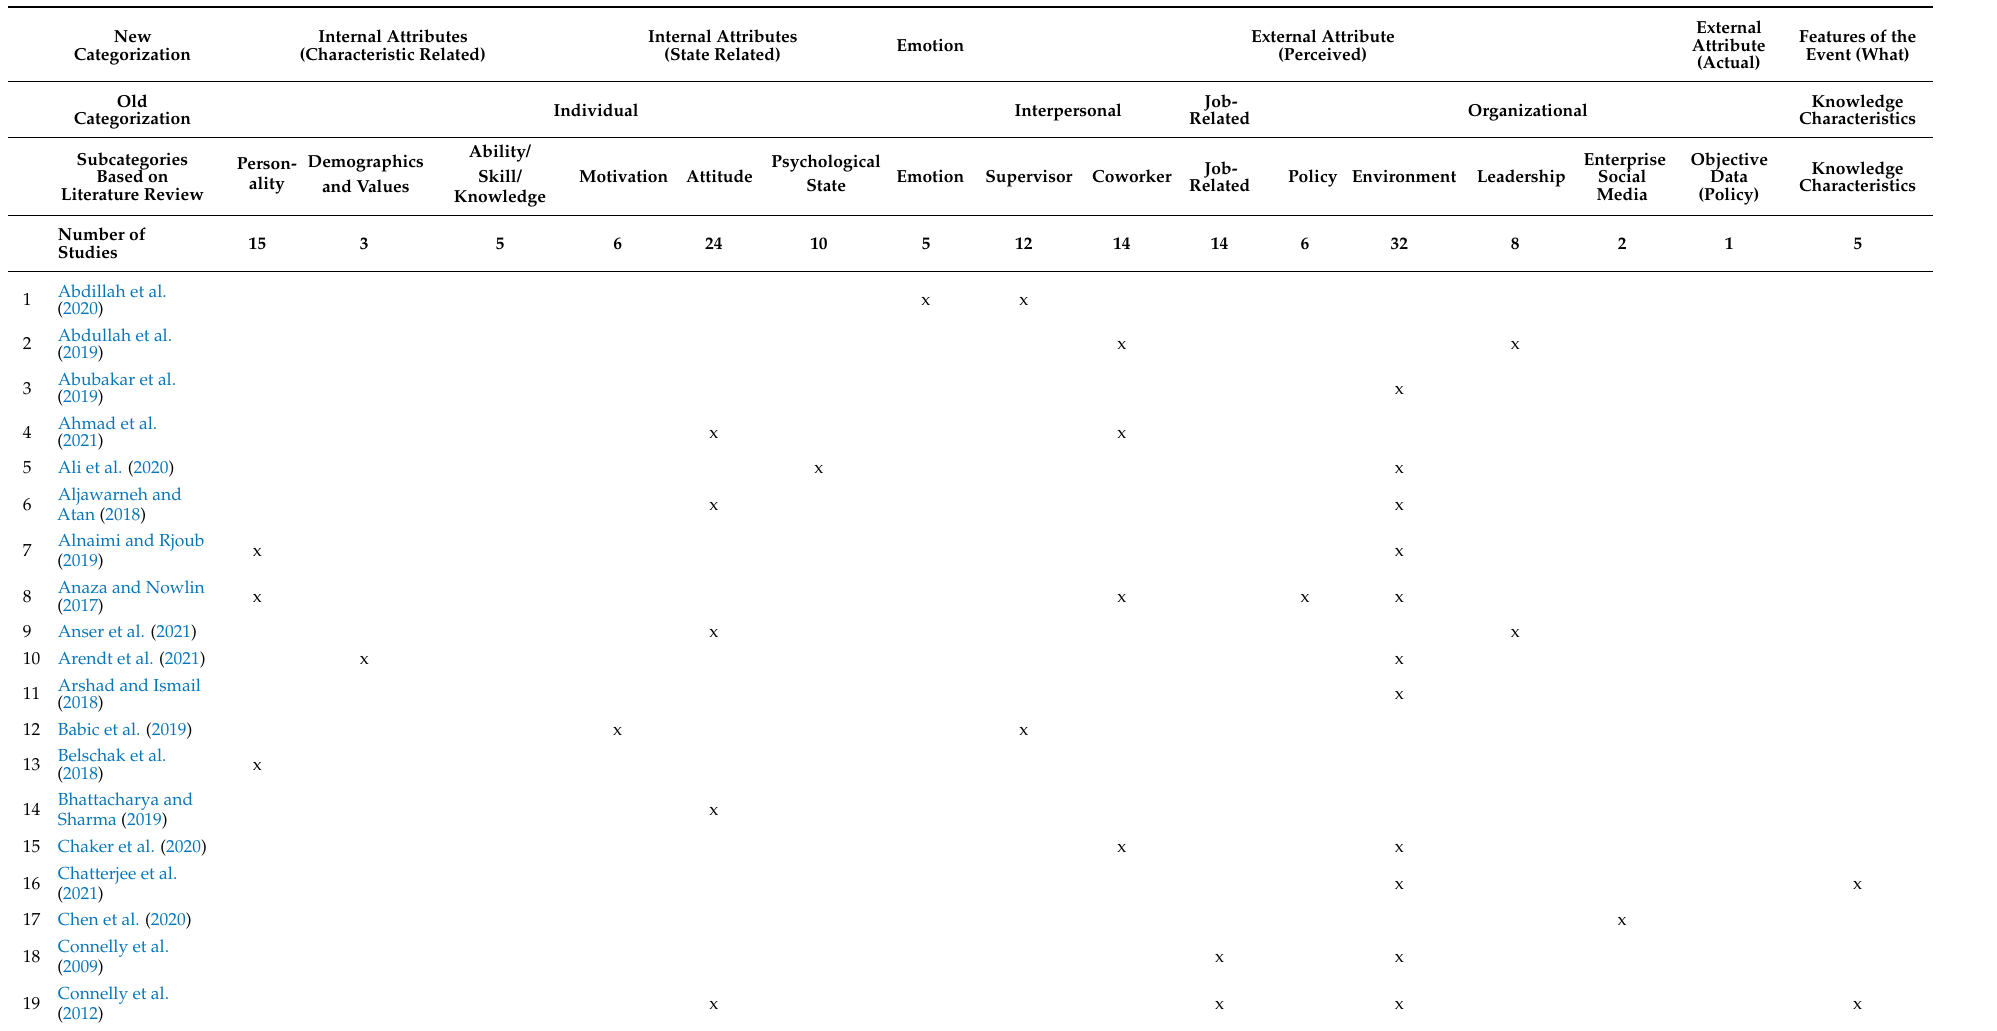
Table 2. Summary of the categories of antecedent variables used in the studies being